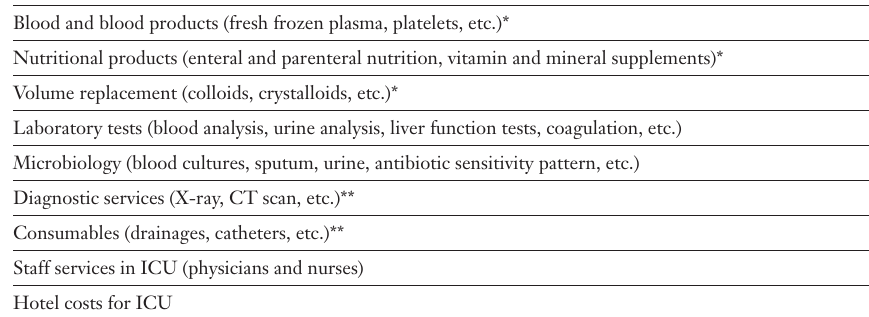
Assessed health care goods and